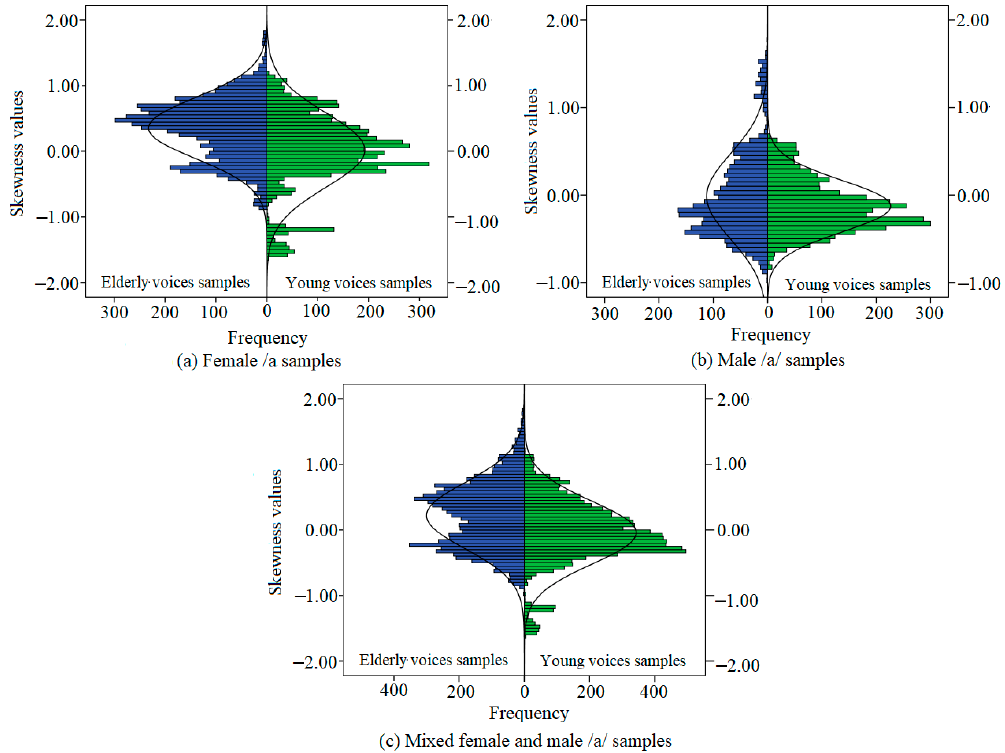
Figure 3. Histograms of skewness extracted from elderly and young voices.